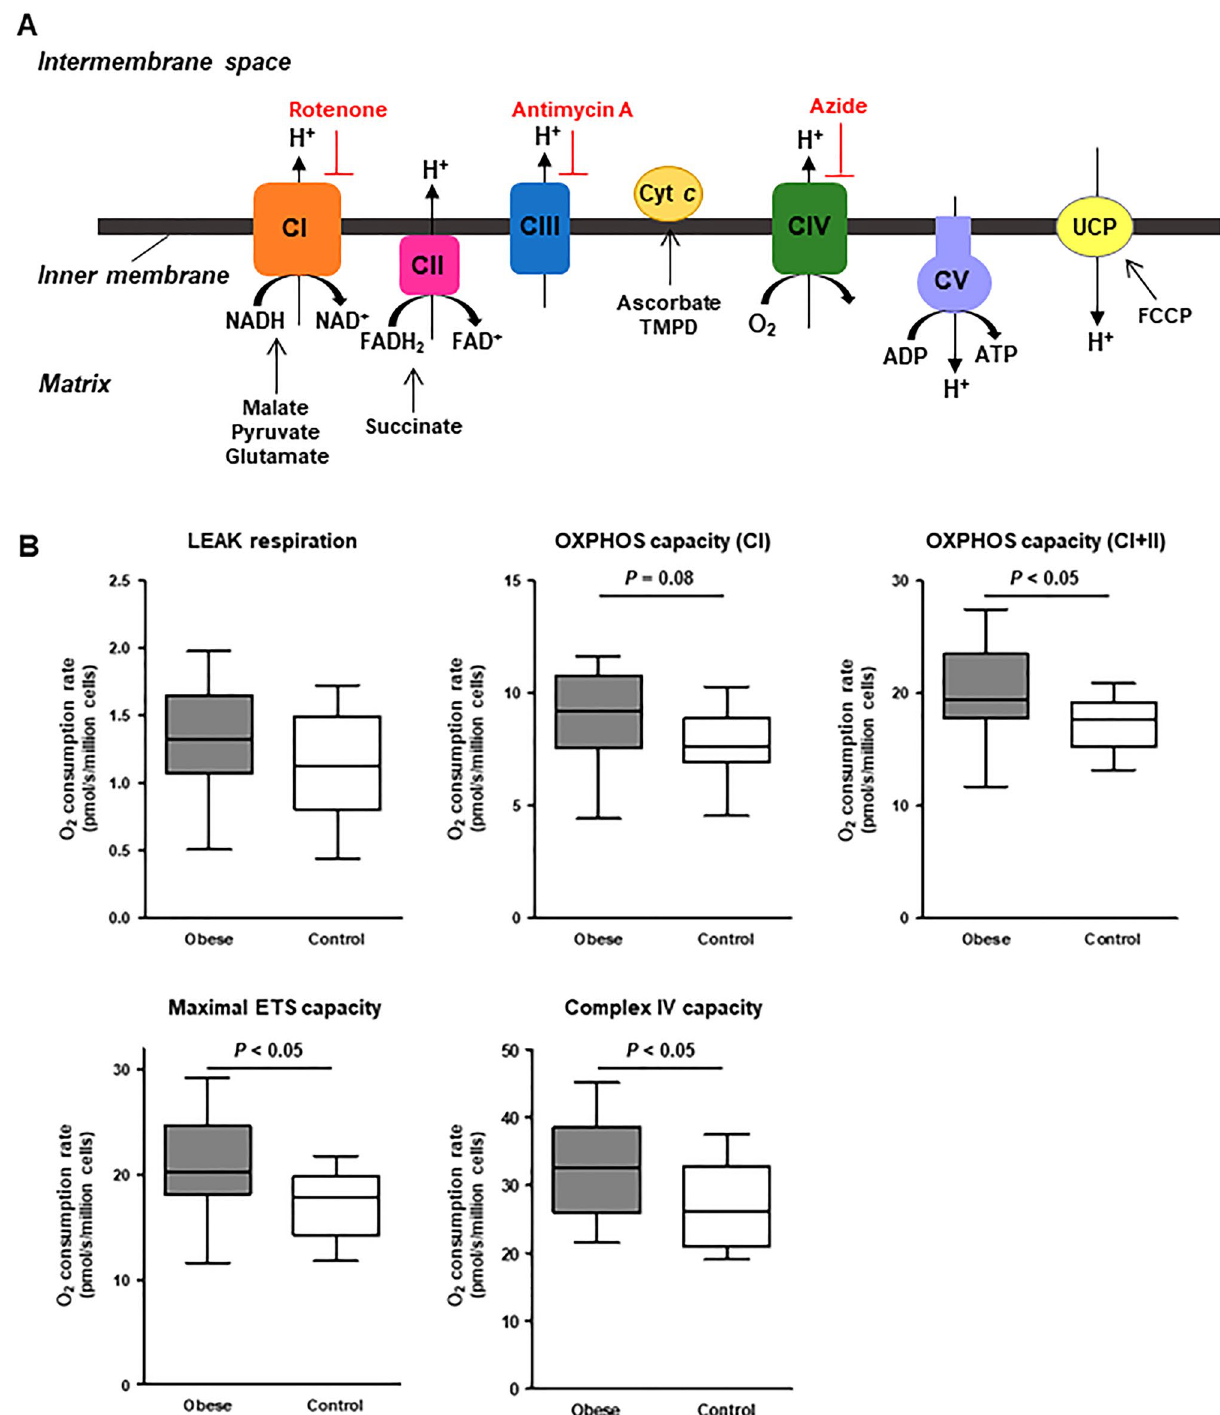
Figure 1. Mitochondrial respiratory capacity in PBMCs. ( A ) Scheme of the mitochondrial electron transfer system (ETS) with the SUIT (substrate–uncoupler–inhibitor–titration) protocol that we used for evaluation of the mitochondrial respiratory capacity in the present study. ( B ) Summarized data of the O 2 consumption rate during each respiratory state with different respiratory substrates in the permeabilized PBMCs of obese (n = 14) and healthy control subjects (n = 15). The box bounds the interquartile range (IQR) divided by the median, and Tukey-style whiskers extend to a maximum of 1.5 × IQR beyond the box. The LEAK respiration indicates non- ADP stimulated respiration (i.e., state 2 respiration) with CI-linked substrates. The oxidative phosphorylation (OXPHOS) capacity, an ADP-stimulated respiration (i.e., state 3 respiration), was measured in the presence of CI− or CI+ II-linked substrates. The maximal ETS capacity was measured after addition of FCCP, an uncoupler, in the presence of CI + CII-linked substrates. The capacity of complex IV was measured after addition of TMPD, an electron donor to cytochrome c (cyt c ), in the presence of ascorbate. CI complex I, CII complex II, CIII complex III, CIV complex IV, CV complex V, UCP uncoupling